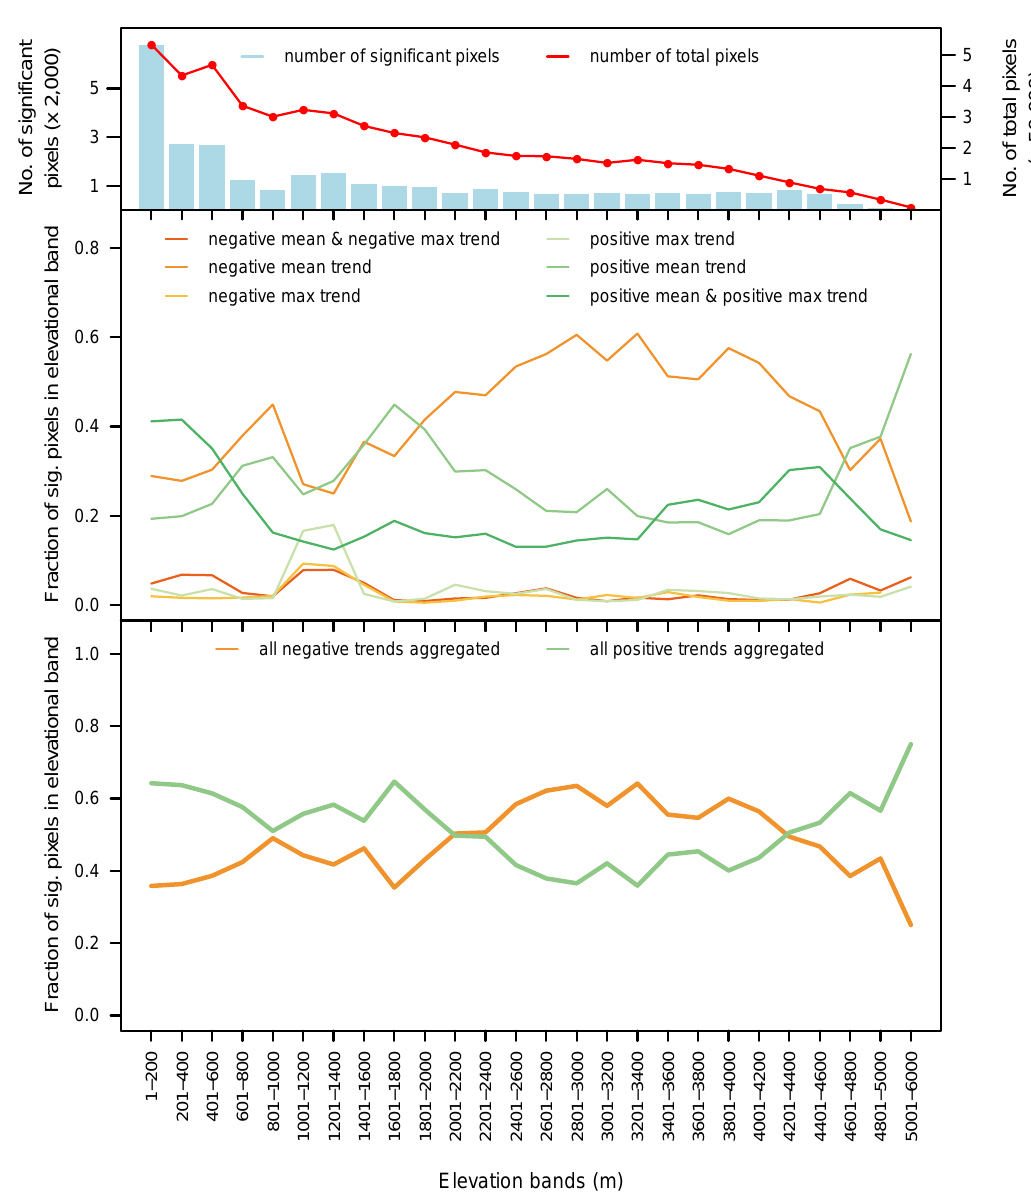
Figure 8. Greening and browning trends in the Drylands by elevation. There is a strong greening signal from sea level to 2000 m, an elevation range where most significant pixels are located. Refer to the caption in Figure 5 for panel